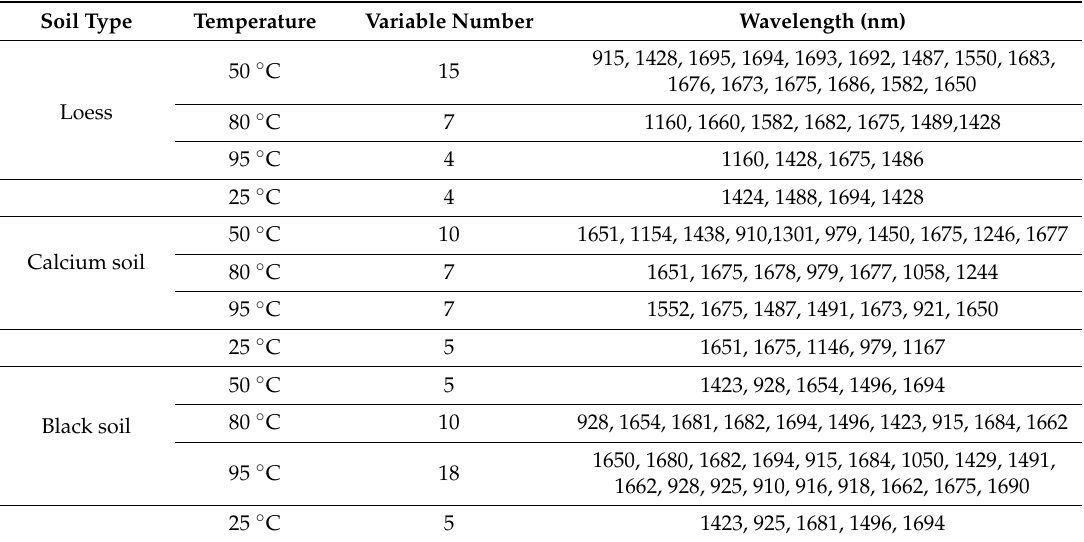
Table 1. Successive projections algorithm based on multiple linear regression (SPA-MLR) algorithm variable number and